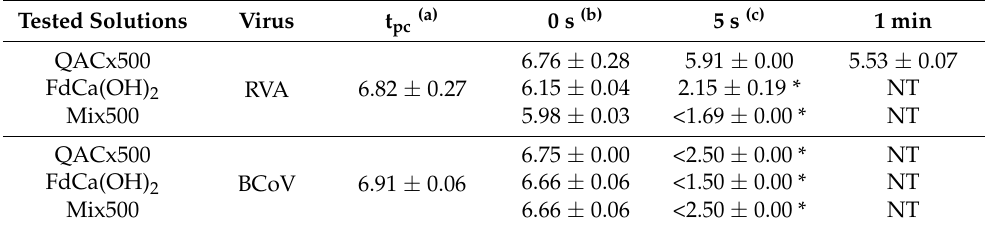
Table 1. Virucidal efficacy of the tested solutions toward bovine rotavirus A (RVA) and bovine coronavirus (BCoV) in aqueous phase containing 5% fetal bovine serum.